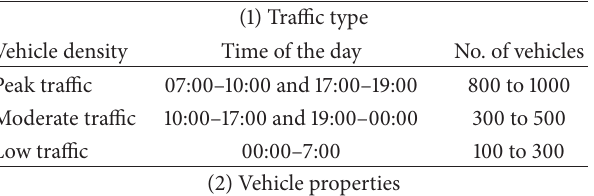
Table 1: Simulation